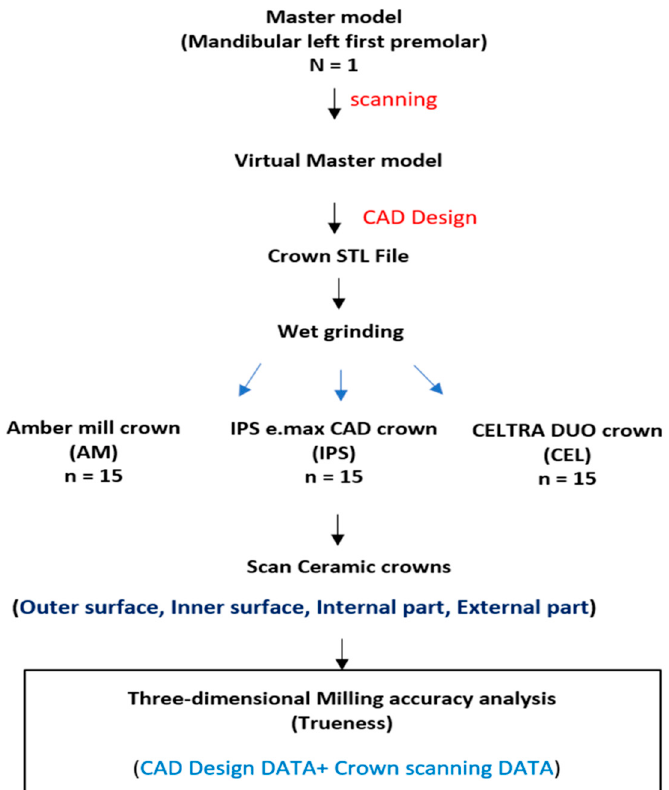
Figure 1. Diagram of the experimental procedure.